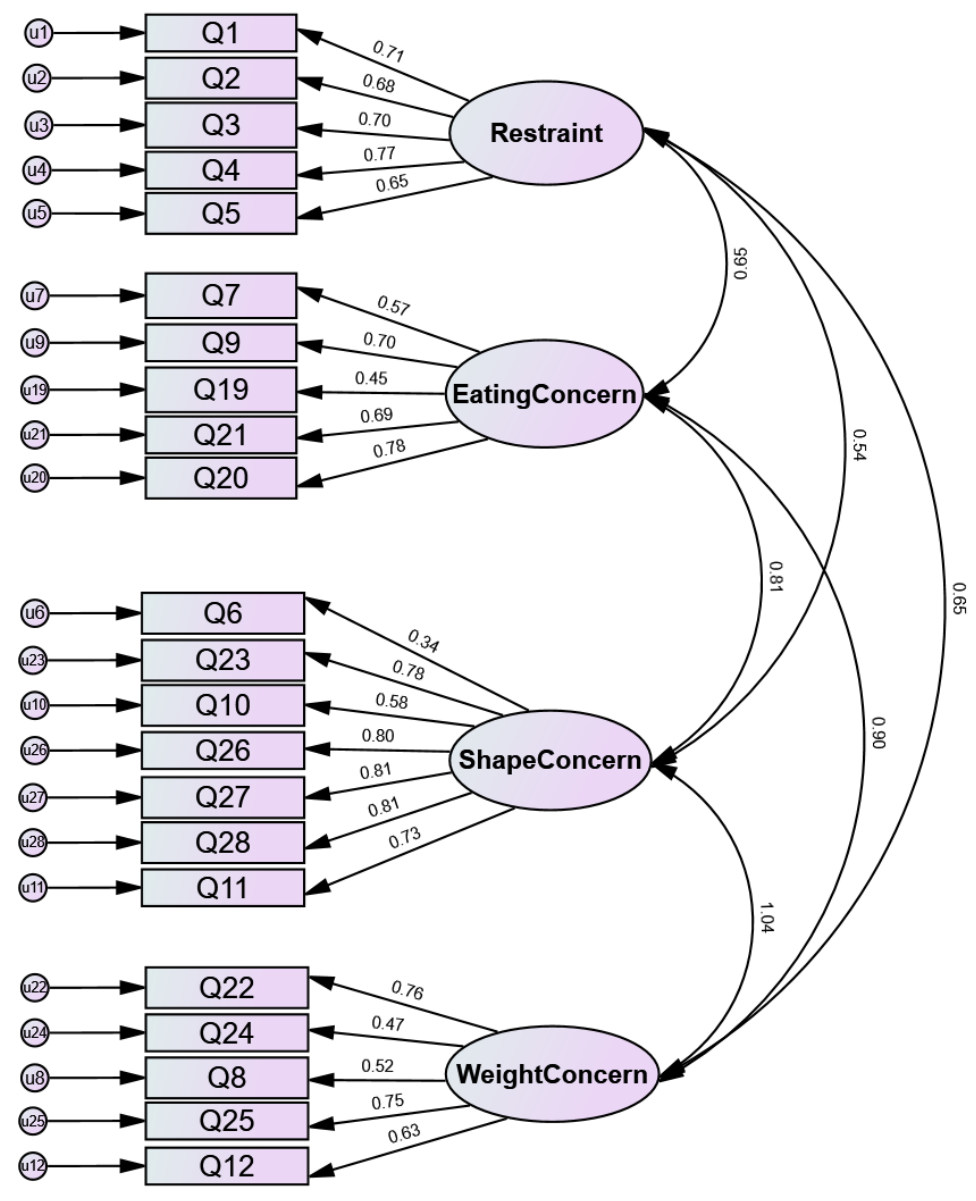
Figure 1. Four-factor model of the original EDE-Q using CFA (Standardized Estimates). Table 2. Goodness of fit for the original four-factor model of the EDE-Q tested by CFA of main dataset and four major provinces of Saudi Arabia.